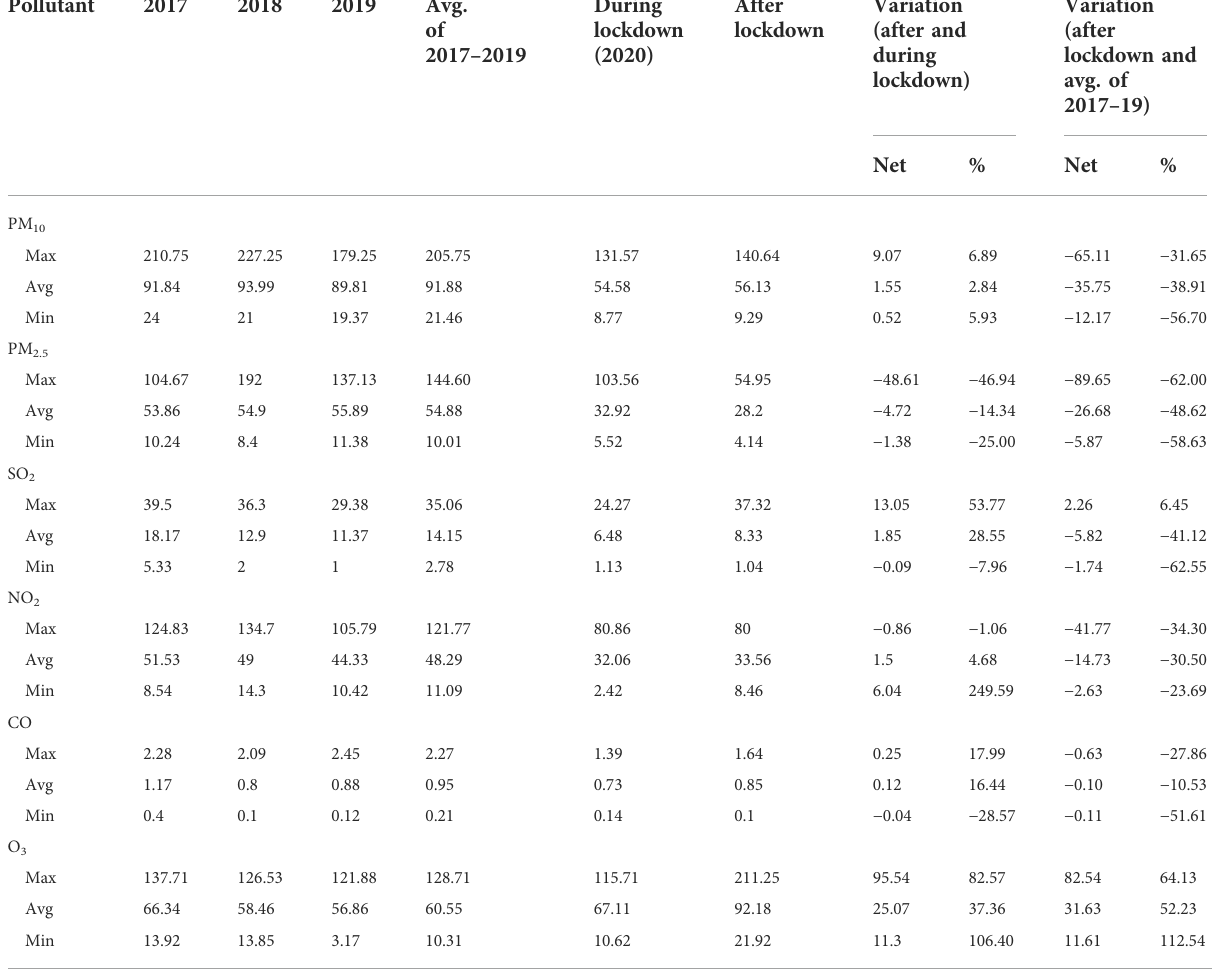
TABLE 3 Daily average concentration and variation of pollutants in different time periods in